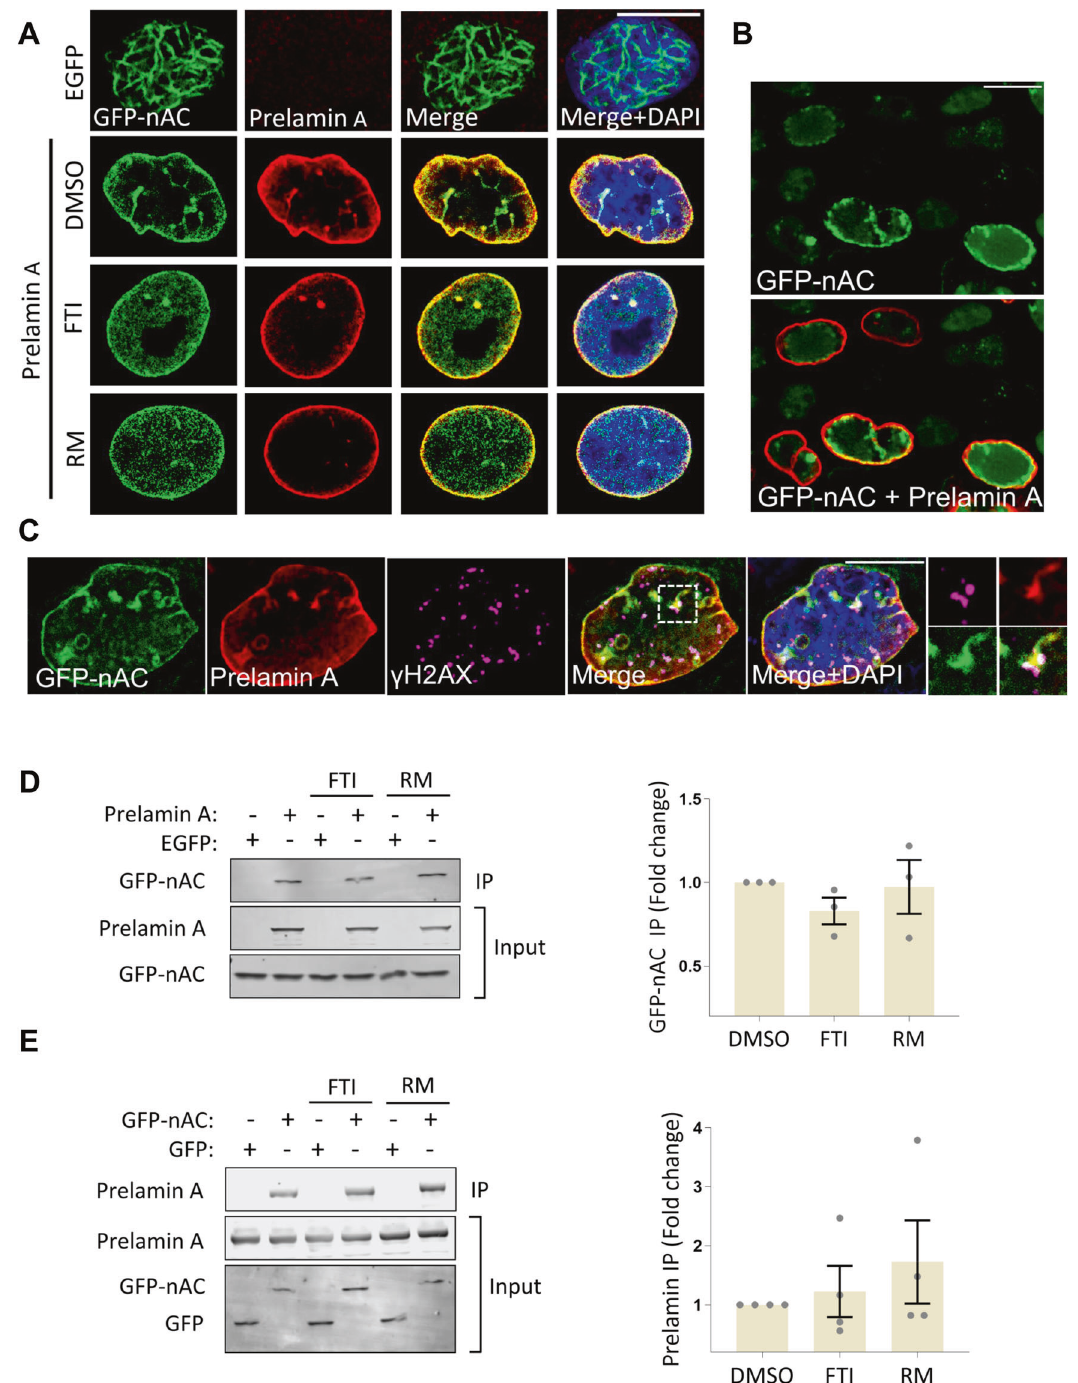
Fig. 3 Prelamin A causes mislocalisation of nuclear actin. A Representative IF images of U2OS + GFP-nAC cells over-expressing prelamin A or EGFP control. Prelamin A (red) causes mislocalisation of nuclear actin (green) to the nuclear envelope (NE). This is not rescued by either farnesyltransferase inhibitor (FTI) or Remodelin (RM) treatment. B IF of U2OS cell line stably expressing GFP-nAC and over-expressing prelamin A (red). The same NE mislocalisation of nuclear actin can be observed. C IF showing triple staining of nuclear actin (green), prelamin A (red) and γ H2AX (magenta) in U2OS + GFP-nAC cells. γ H2AX is observed trapped in nucleoplasmic reticulum (magni fi ed image) and at the NE alongside prelamin A and actin but the majority of foci no longer associate with the nuclear F-actin network. DNA is stained with DAPI (blue). All scale bars = 10 µm. D Representative WB and quanti fi cation of FLAG-IP assays investigating prelamin A and nuclear actin interactions in U2OS cells expressing FLAG-tagged prelamin A and GFP-nAC and treated with DMSO, FTI or RM. Cells expressing EGFP and GFP-nAC were used as negative controls ( n = 3). E GFP-trap representative WB and quanti fi cation of assays using GFP-nAC as bait to test for interactions with prelamin A in U2OS cells expressing GFP-nAC and prelamin A. Cells expressing GFP instead of GFP-nAC were used as negative controls. The effect of adding FTIs and RM on nuclear actin – prelamin A interactions was tested ( n = 4). Data were presented as mean ± SEM and were analysed by one-way ANOVA and Tukey ’ s test.